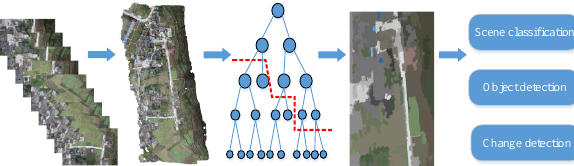
Figure 2. A brief schematic diagram for UAV image